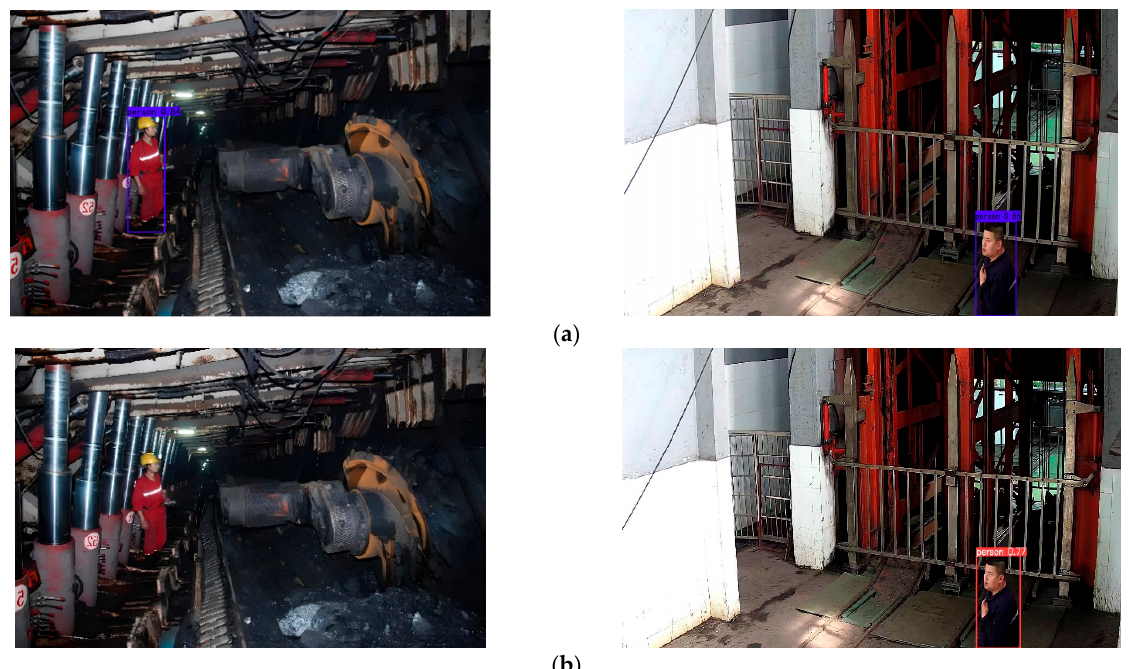
Figure 14. Comparison of results between ST-YOLOv5 and YOLOv5. ( a ) ST-YOLOv5 model detection. ( b ) YOLOv5 model detection.